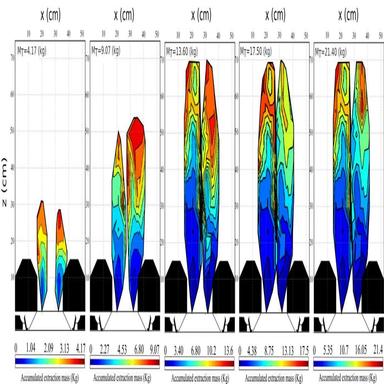
Evolution of the ellipse to different accumulated extraction mass with 4% moisture content - tests with draw from two drawpoints - longitudinal view to the drawbell.